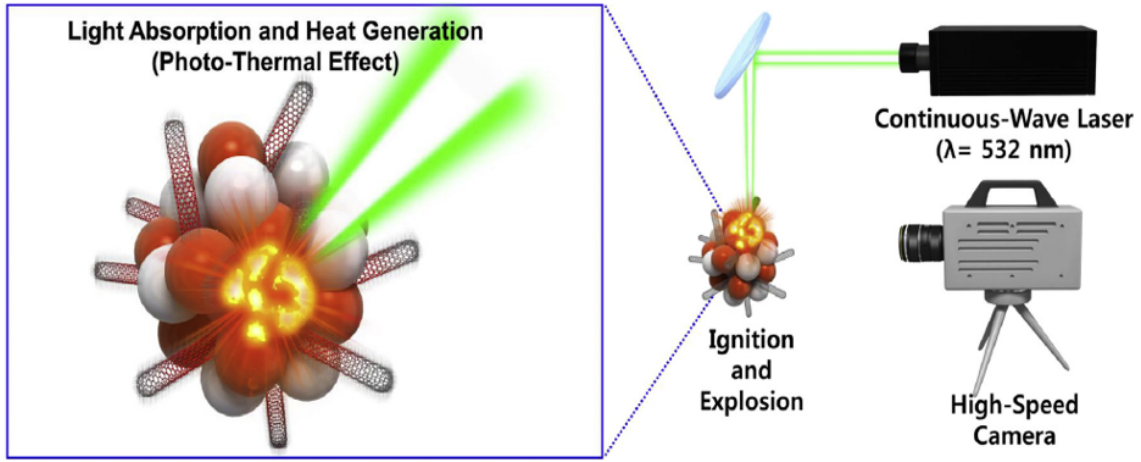
Figure 3: Schematic view of laser ignition experimental test, carried out by the authors in [16] by using MWCNT/Al NP/CuO NP